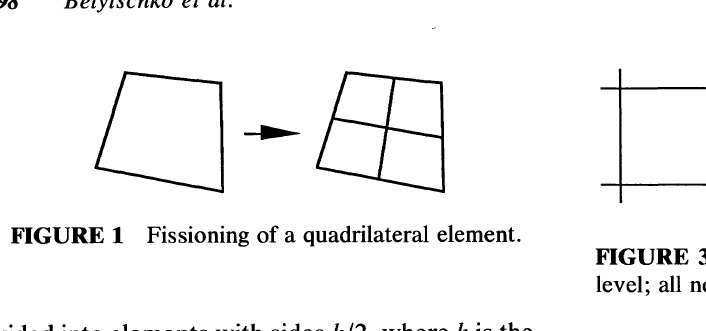
FIGURE 3 Quadrilateral element fissioned to third level; all nodes not labeled are master